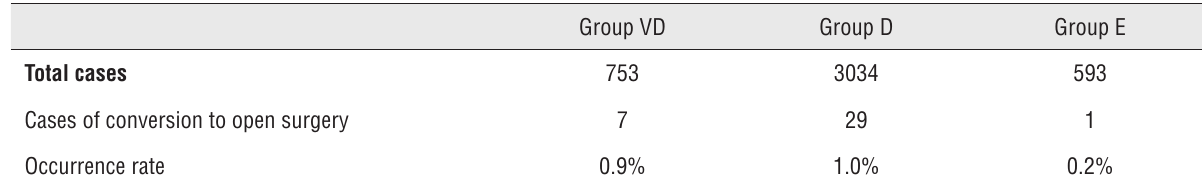
Table 3 - The sum of the intraoperative conversion to open surgery among VD, D, and E groups.